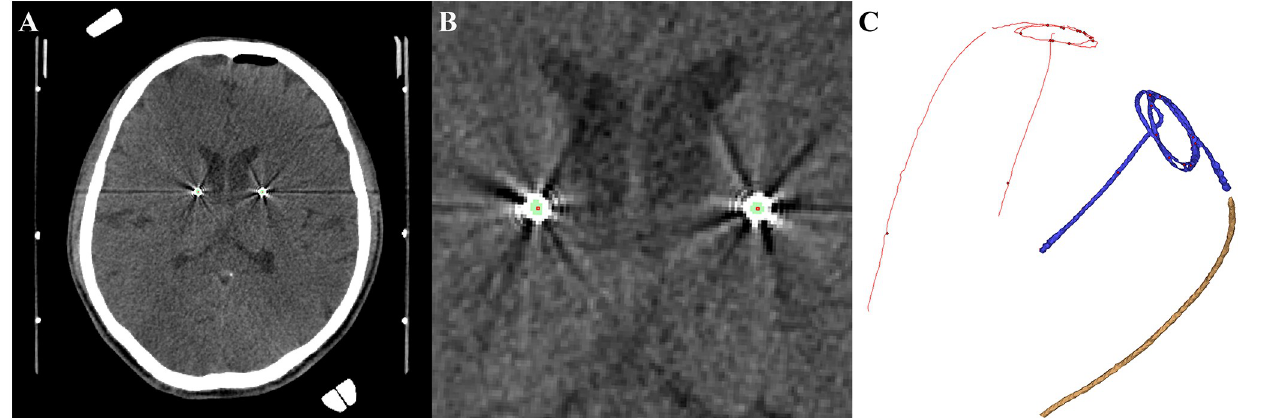
Fig 2. Process of 3-dimensional reconstruction and centerline rendering. A. A postoperative brain computed tomography scan was used in the calculation. B. Green indicates intracranial leads, which were defined as an area of Hounsfield units exceeding 2700, and red indicates the centerline rendered with software logic. C. Reconstructed intracranial lead (right side, volume rendered) and rendered centerline (left side, red).